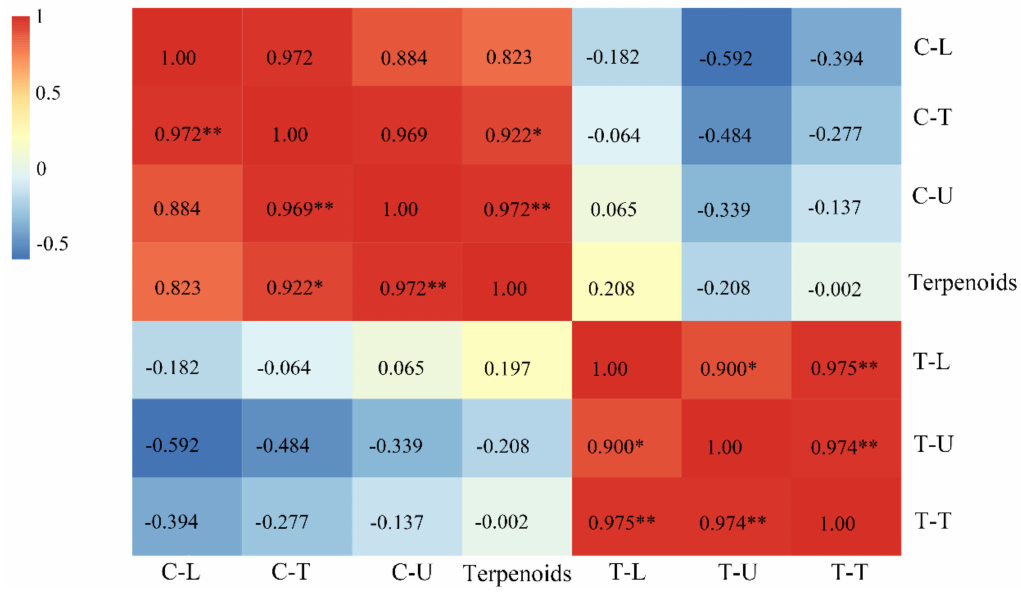
Figure 8. Correlation analysis of the content of terpenoids and the density of trichomes on the surface of leaves (T-shaped and capitate trichomes). **, p < 0.01; *, p < 0.5 level; C-U, C-L, and C-T, the density of capitate trichomes on the upper, lower and whole surface (total density of capitate trichomes) of leaves, respectively; T-U, T-L, and T-T; the density of T-shaped trichomes on the upper, lower and whole surface (total density of T-shaped trichomes)of the leaves, respectively. Terpenoids represent the content of terpenoids on the leaves.